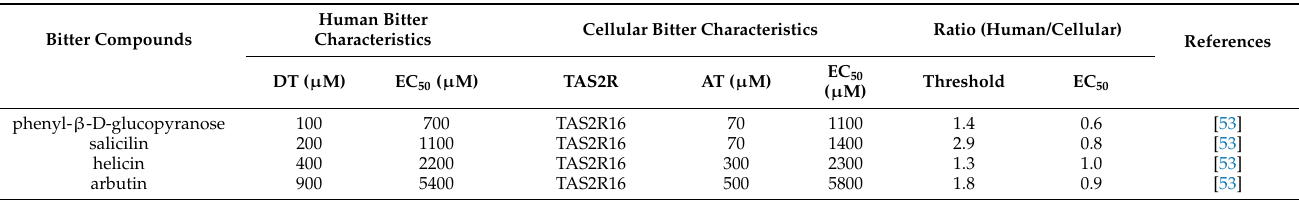
Table 1. Comparison between human (in vitro) and cellular (in vivo) bitter characteristics for differ- ent